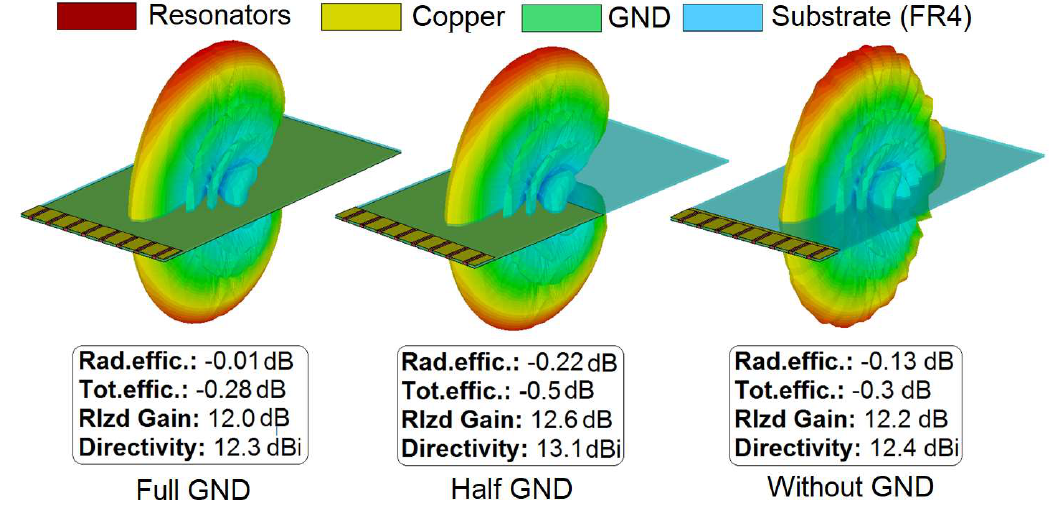
Figure 19. Fundamental radiation properties of the antenna with different sizes of the ground plane. Table 2. Comparison between the proposed and the reported mobile handset